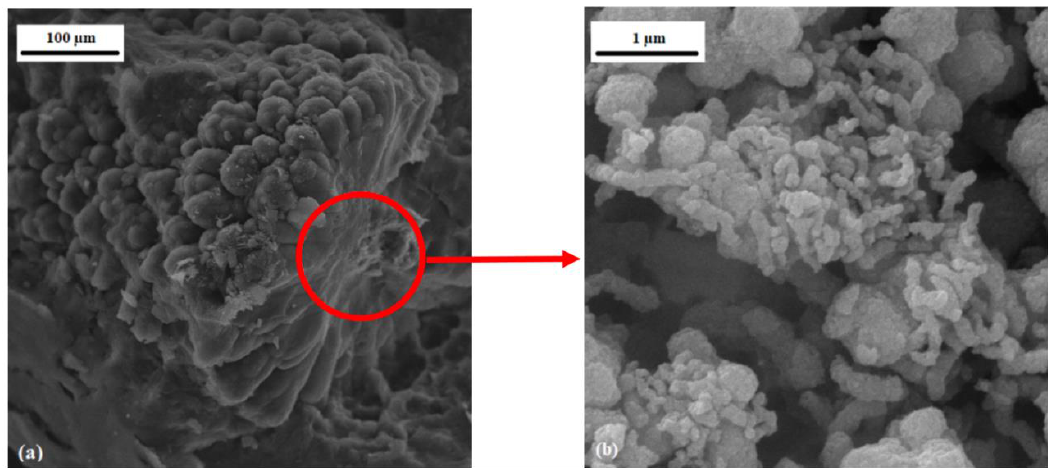
Figure 3. SEM images of ( a ) a bulk nanoparticle strand and ( b ) a zoomed in image of the marked area